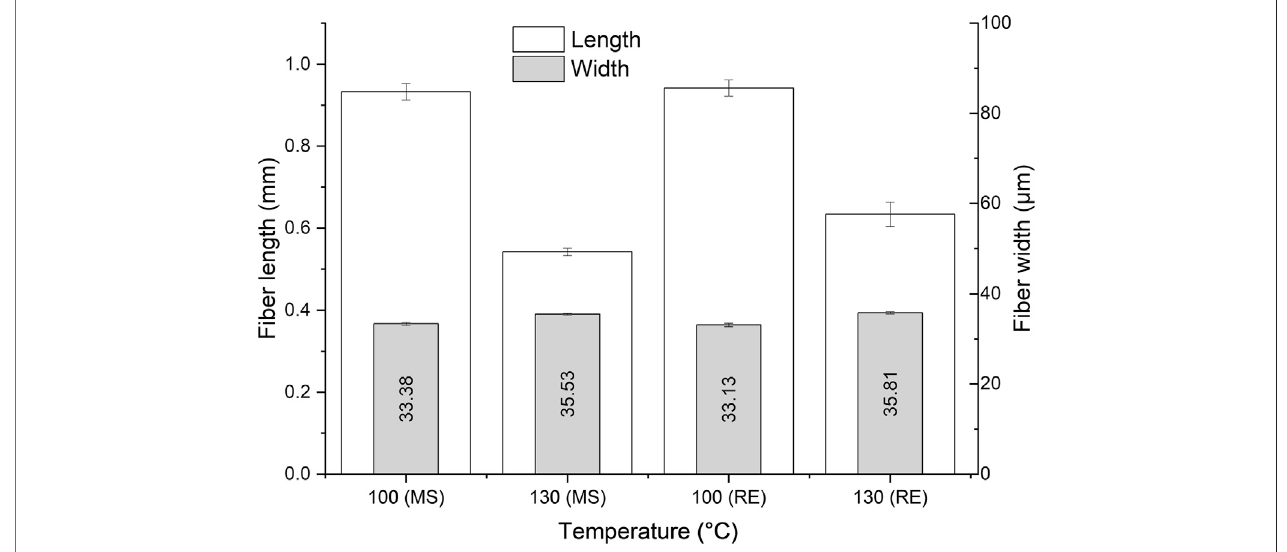
FIGURE 4 | The effect of the temperature and the kind of mixing on the fi ber length and width in the DES-cooking of Asplund (1 h of cooking and the L/W at 27:1).